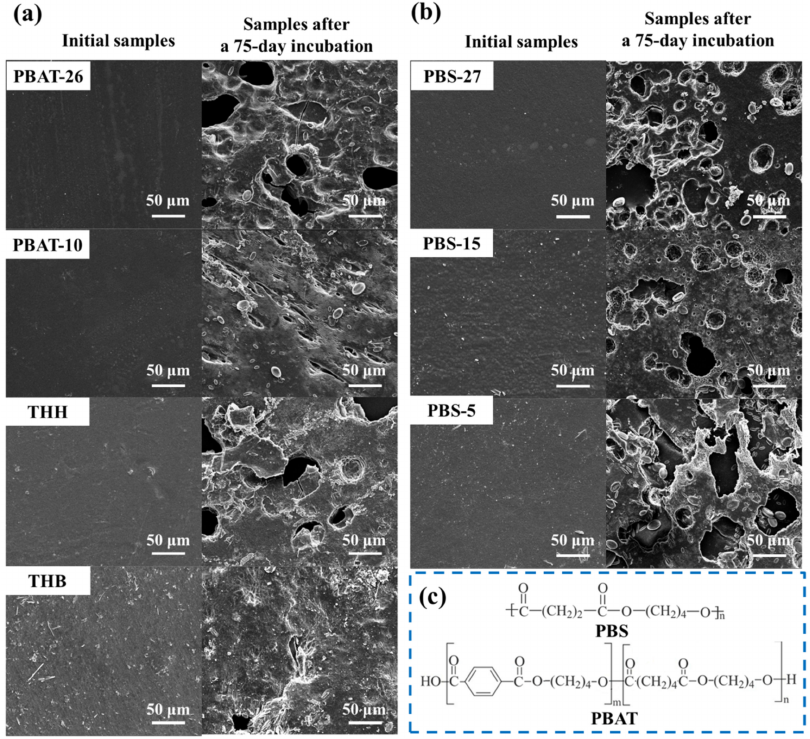
Figure 1. SEM images of ( a ) PBAT film with different carboxyl end group content (PBAT-26 and PBAT-10), PBAT film filled with carbon black (THH) and CaCO 3 (THB) before and after a 75-day degradation; ( b ) PBS film with different molecular weight (PBS-27, PBS-15 and PBS-5) before and after a 75-day degradation. ( c ) Molecular structure of PBS and PBAT.